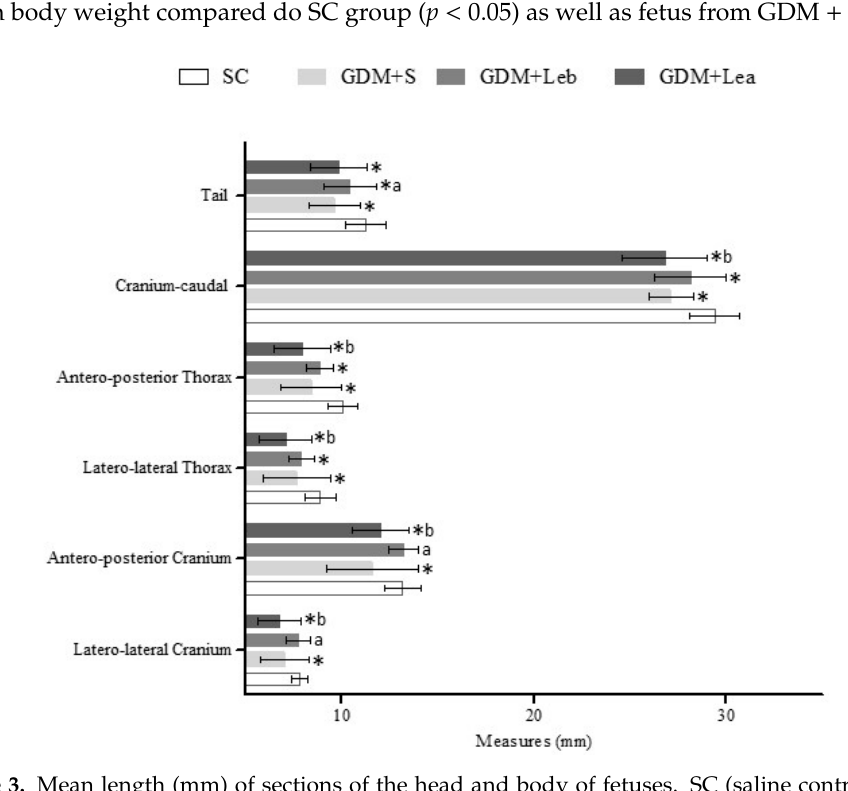
Figure 3. Mean length (mm) of sections of the head and body of fetuses. SC (saline control 0.9%), GDM + S (diabetic + saline solution 0.9%), GDM + Leb (diabetic + 100 mg/kg/day of Lentinus